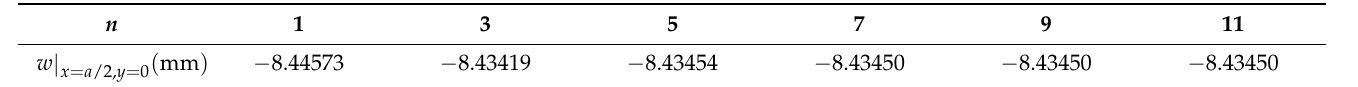
Figure 3. The bending deflection diagram. Table 2. The bending deflections for a uniformly loaded thin